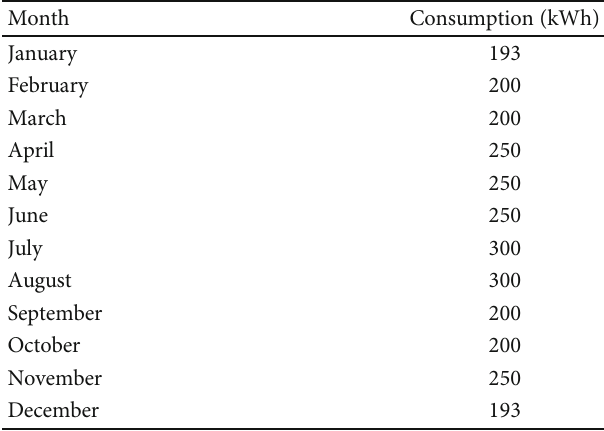
Table 10: Monthly energy consumption in